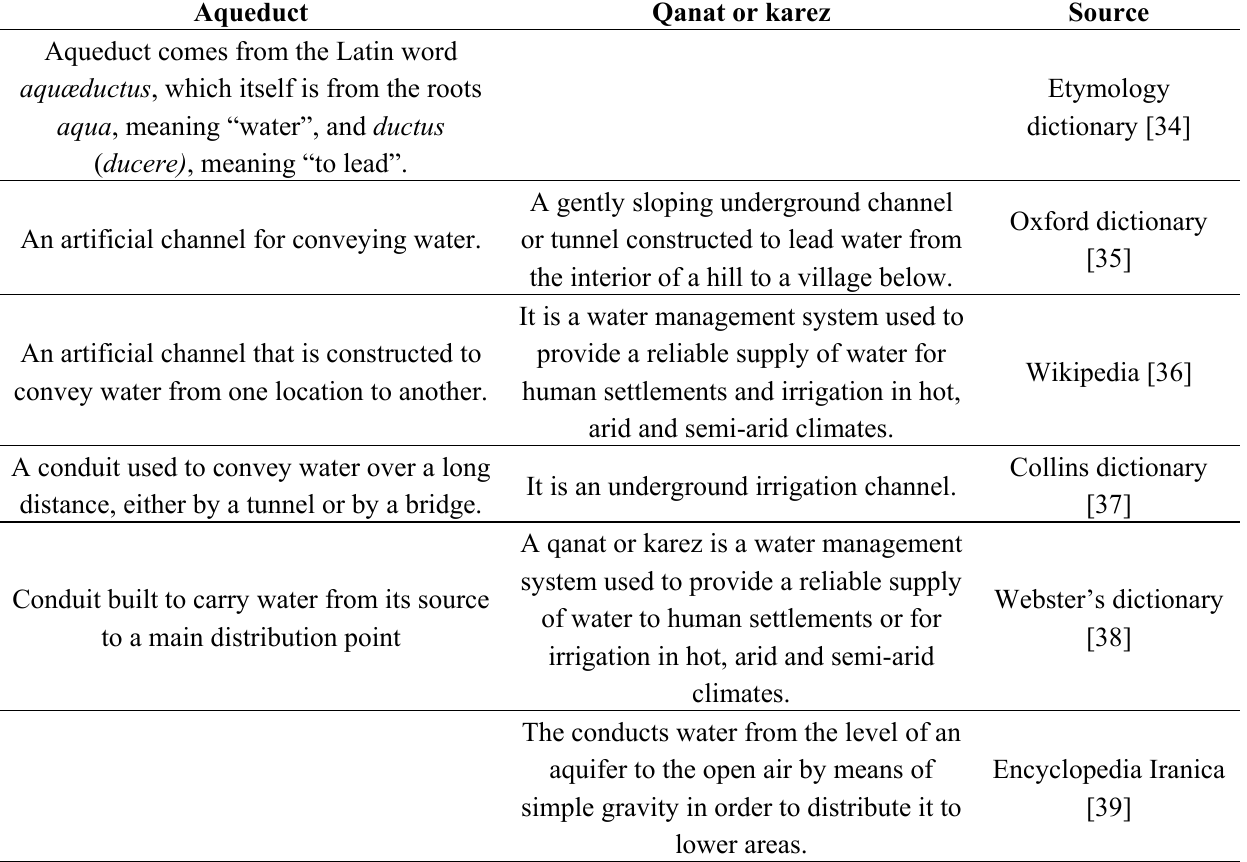
Table 1. Etymology and/or definition of the terms “aqueduct” and “qanat”. Aqueduct Qanat or karez